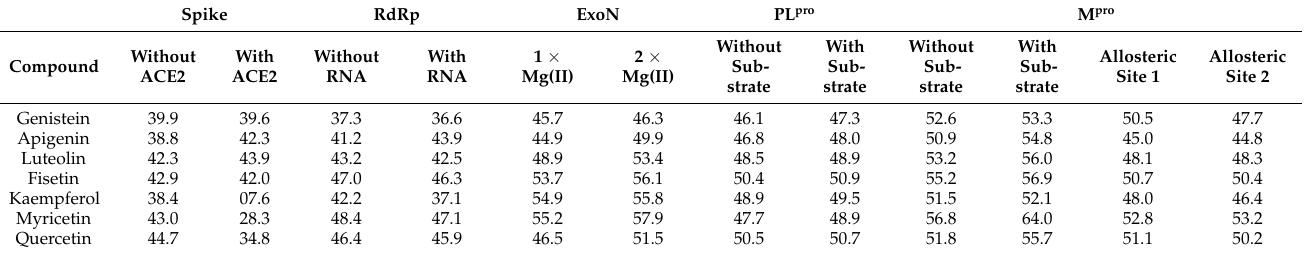
Table 2. Docking score values (dimensionless) for the flavonoids in spike, RdRp, ExoN, PL pro , and M pro